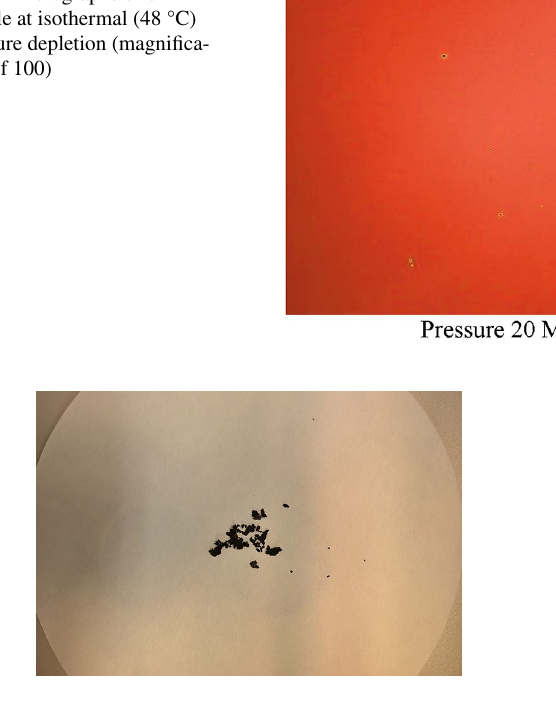
Fig. 5 Micrographs of oil sample at isothermal (48 °C) pressure depletion (magnifica- tion of 100)